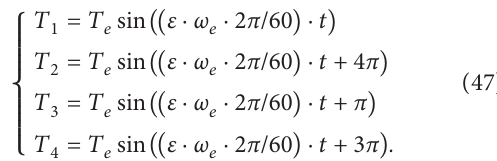
Figure 36: The rotary speed curves of the primary flywheel and the input shaft of the gearbox matching the DMF under driving conditions.